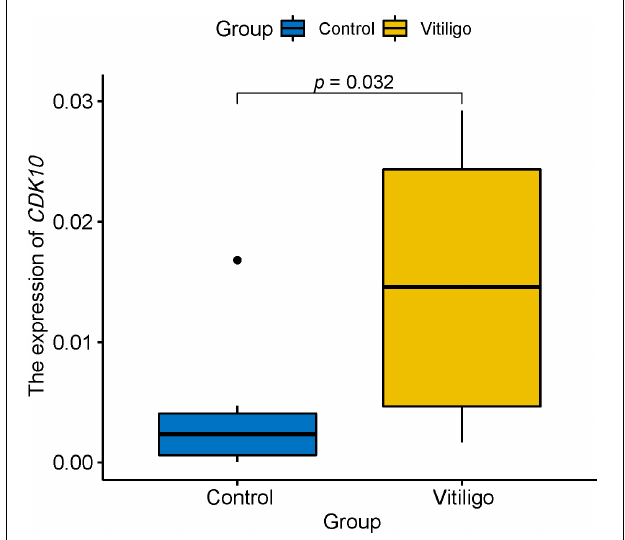
FIGURE 2 | qRT-PCR showed the expression of CDK10 is significantly increased in the blood of vitiligo relative to